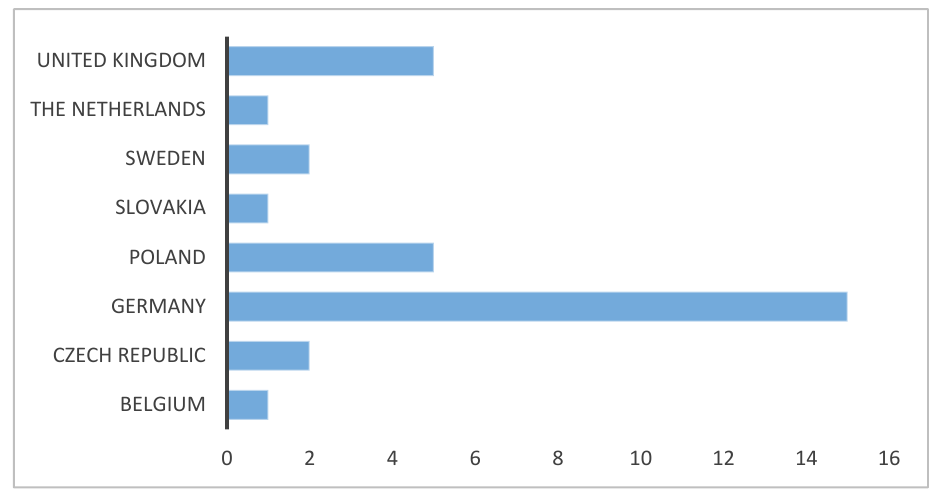
Figure 2. Publications on Carabidae in energy willow and poplar plantations—number per country. Articles found in three scientific databases: International Web of Science, Scopus, and CEON Biblioteka Nauki after discarding unrelated works and duplicated records.